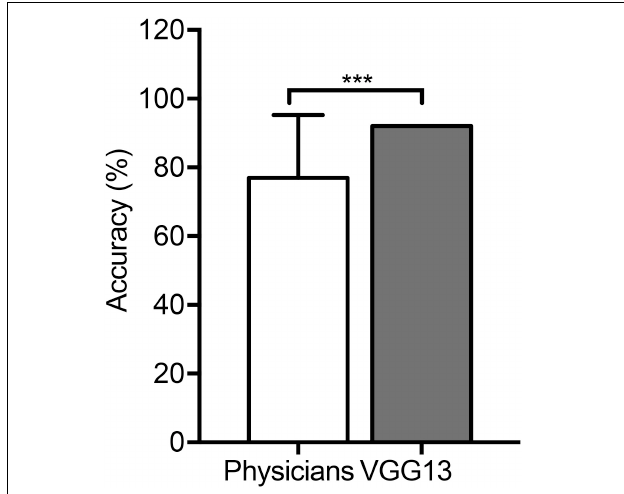
FIGURE 5 | Comparison in the VGG13 model and physicians. An average accuracy (%) of pattern identification between the VGG13 model and 90 physicians. *** P <